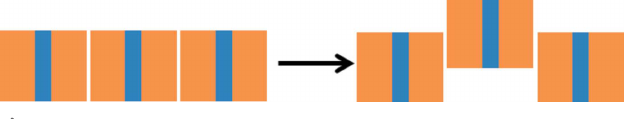
Figure 4 Schematic of the typical bilayer displacement during solid-state phase transitions in linear-chain amino